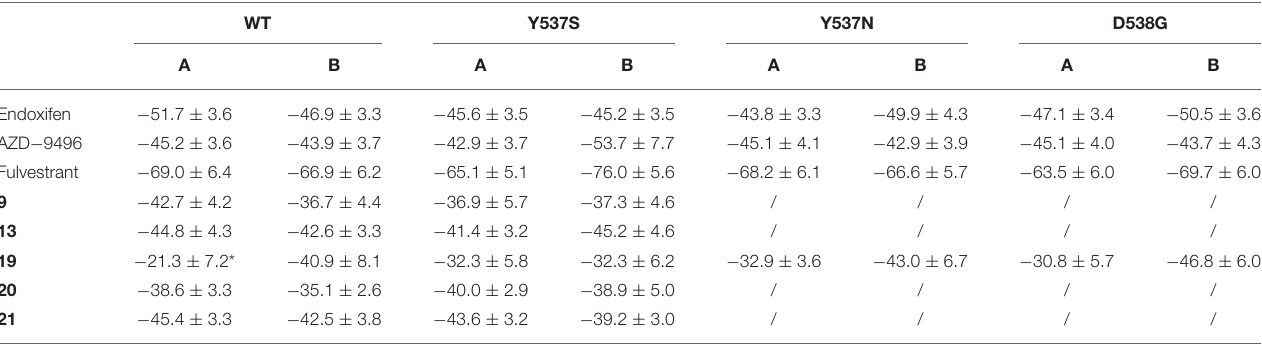
TABLE 1 | Binding free energies ( 1 G b , kcal/mol) of the ligands 9 , 13 , 19 , 20 , and 21